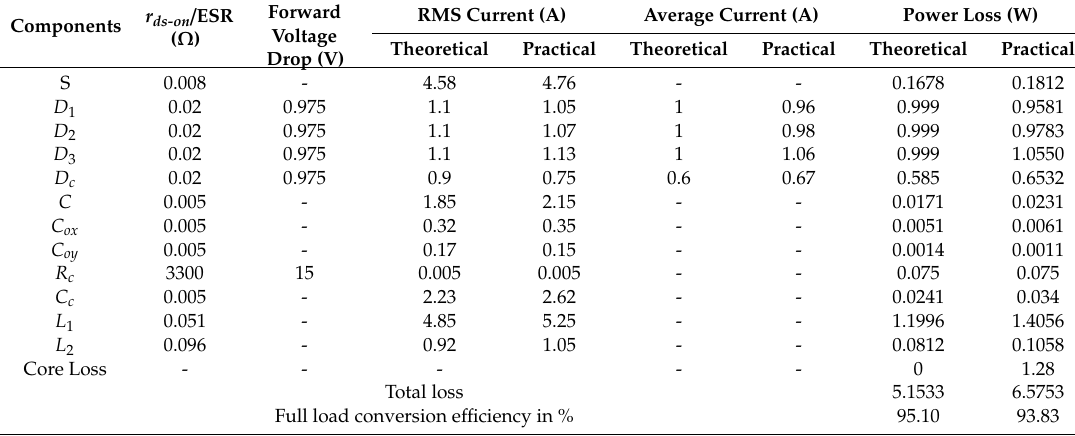
Figure 14. Voltage stress of the MOSFET switch with and without RCD clamp circuit.